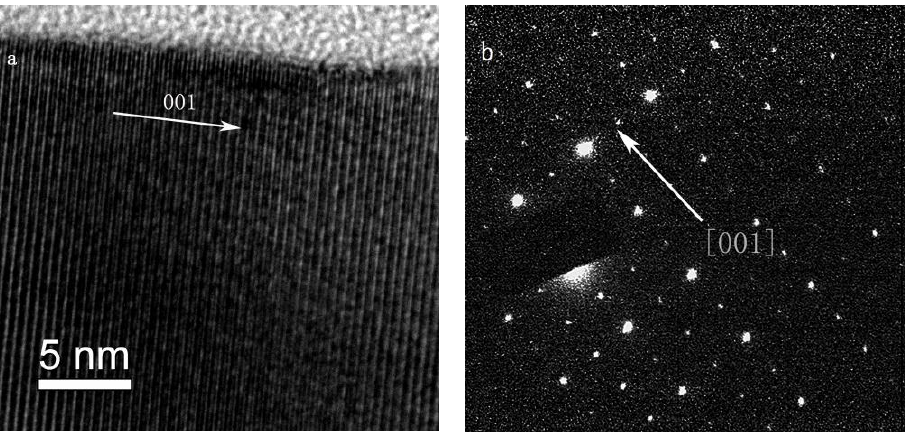
Figure 4. ( a ) HRTEM image of a typical single ITO crystal area; ( b ) an associated selected-area electron diffraction pattern.